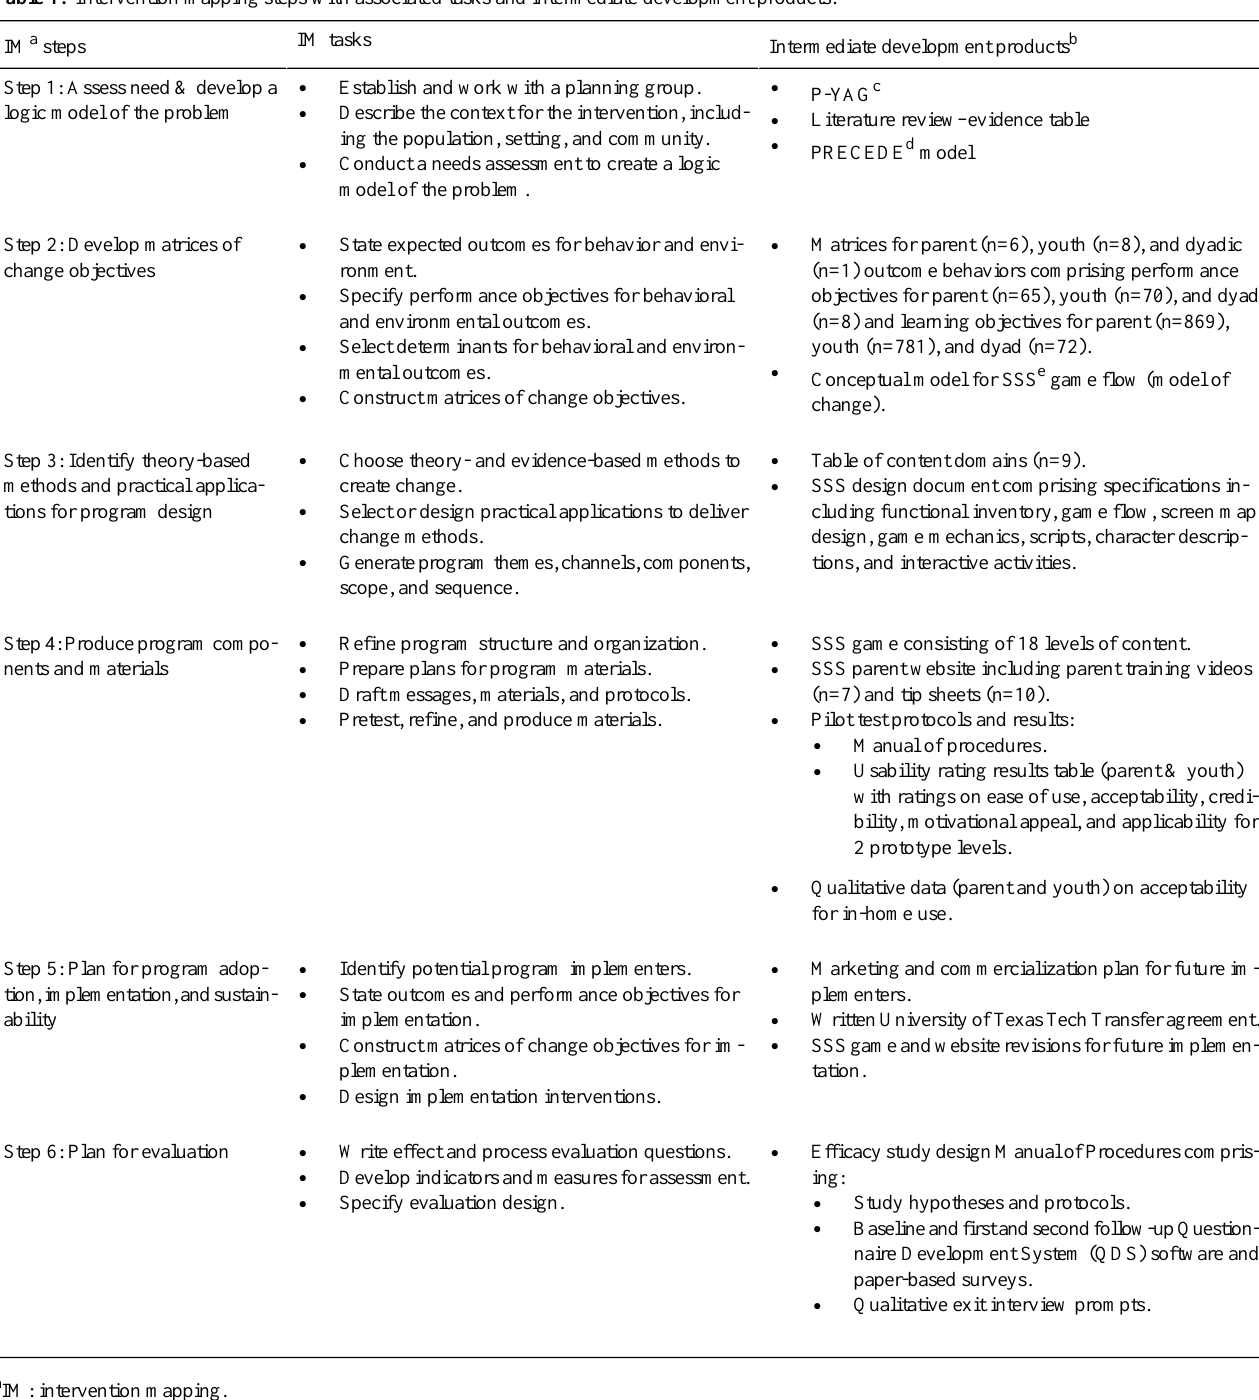
Table 1. Intervention mapping steps with associated tasks and intermediate development products.